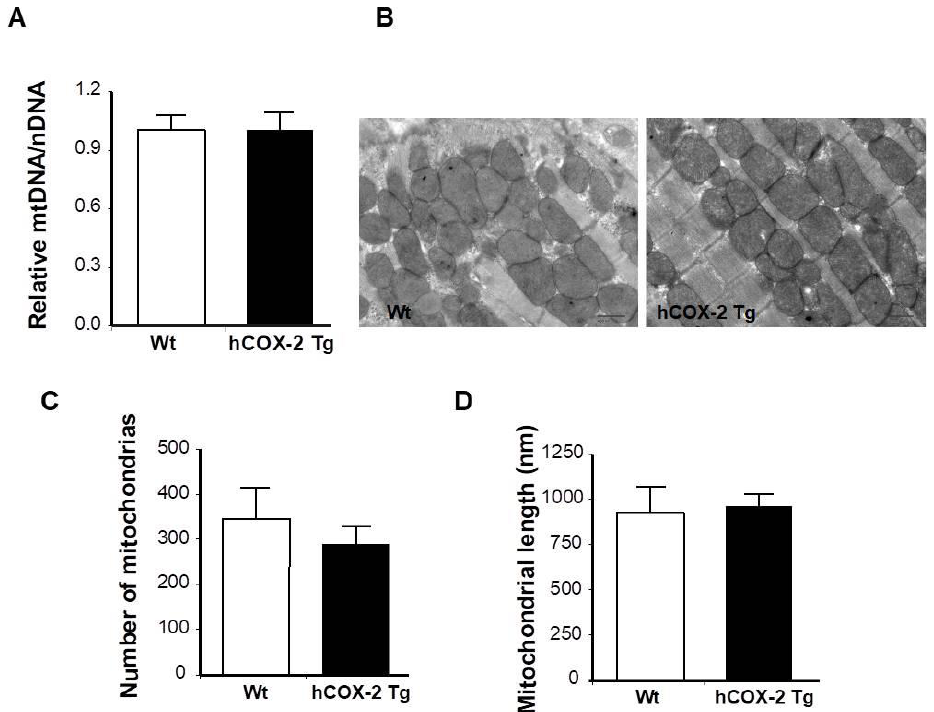
Figure 1. Mitochondrial biogenesis in hCOX-2 Tg mice. ( A ) Mitochondrial-to-nuclear DNA ratio was determined in hearts from Wt ( n = 13) and hCOX-2 Tg ( n = 16) mice by real-time PCR. Data are expressed relative to Wt animals. ( B ) Transmission electron microscopic micrographs of hearts from Wt or hCOX-2 Tg mice. Original magnification ×6000. Mitochondria density ( C ) and size ( D ) were analyzed. Data are means ± SD, n = 15 fields per heart.